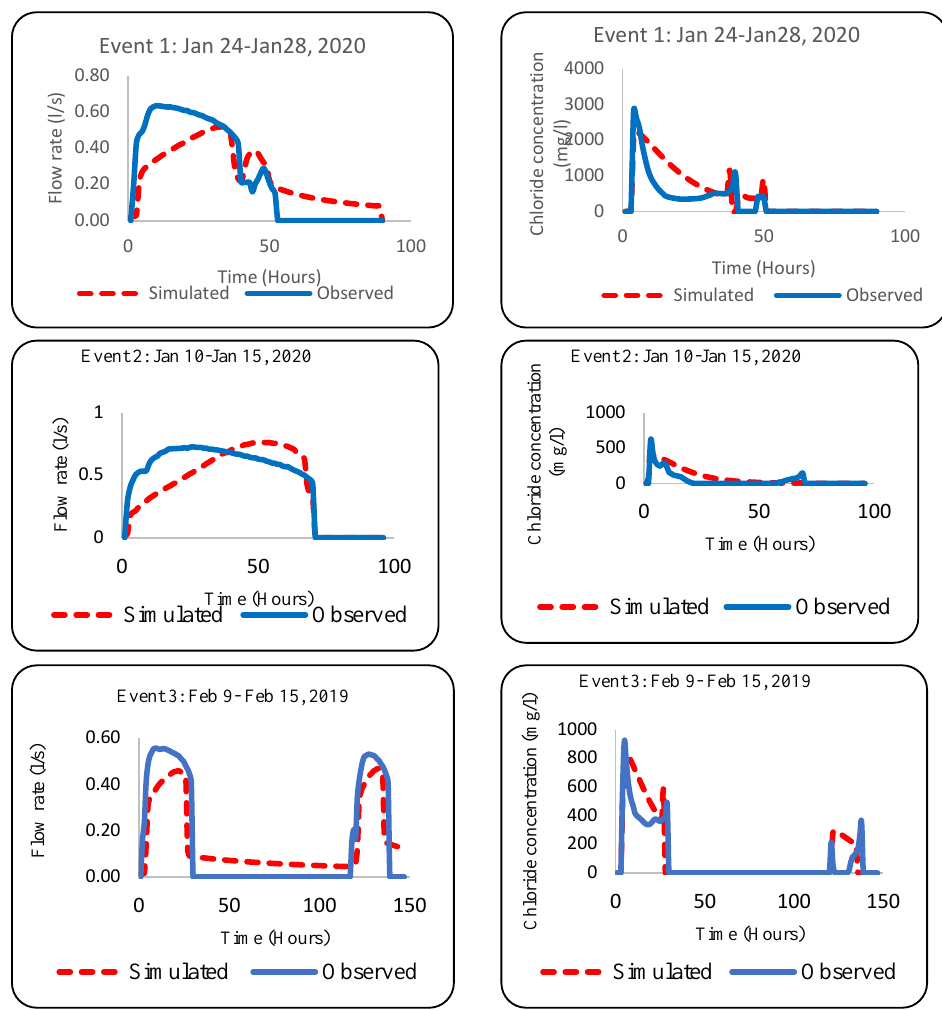
Figure 7. Flow rate and chloride concentration in the case study site on Highway 412.